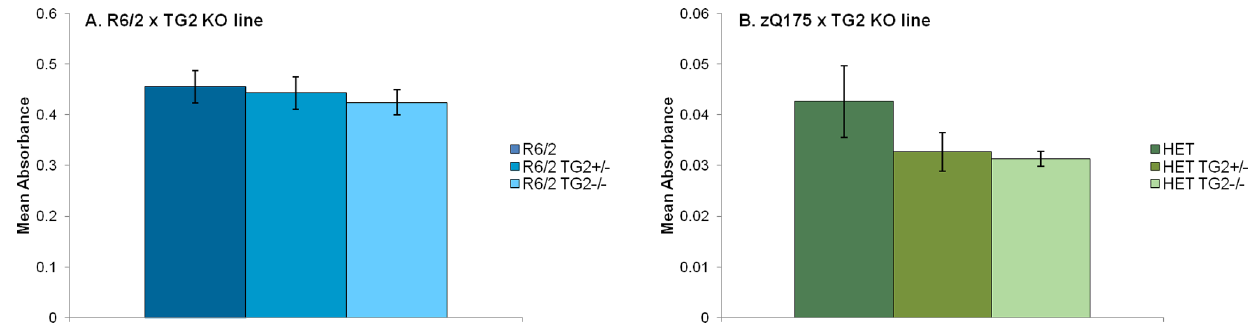
Figure 13. Seprion ligand quantification of aggregate load. A. Aggregate load in cortical tissues from 12-week-old R6/2 6 TG2 KO mice. The background readings obtained from the WT animals (n=3 per group) were averaged and subtracted from the readings obtained from the R6/2 animals in order to remove the baseline reading. B. Aggregate load in striatal tissues from 52-week-old zQ175 6 TG2 KO mice. The readings obtained from the zQ175_WT animals (n=5–7 per group) were averaged and subtracted from the readings obtained from the zQ175_HET animals in order to remove the baseline reading. WT: wild-type, TG2 + / 2 : heterozygous TG2 knockout, TG2 2 / 2 : homozygous TG2 knockout, HET: zQ175 HET.